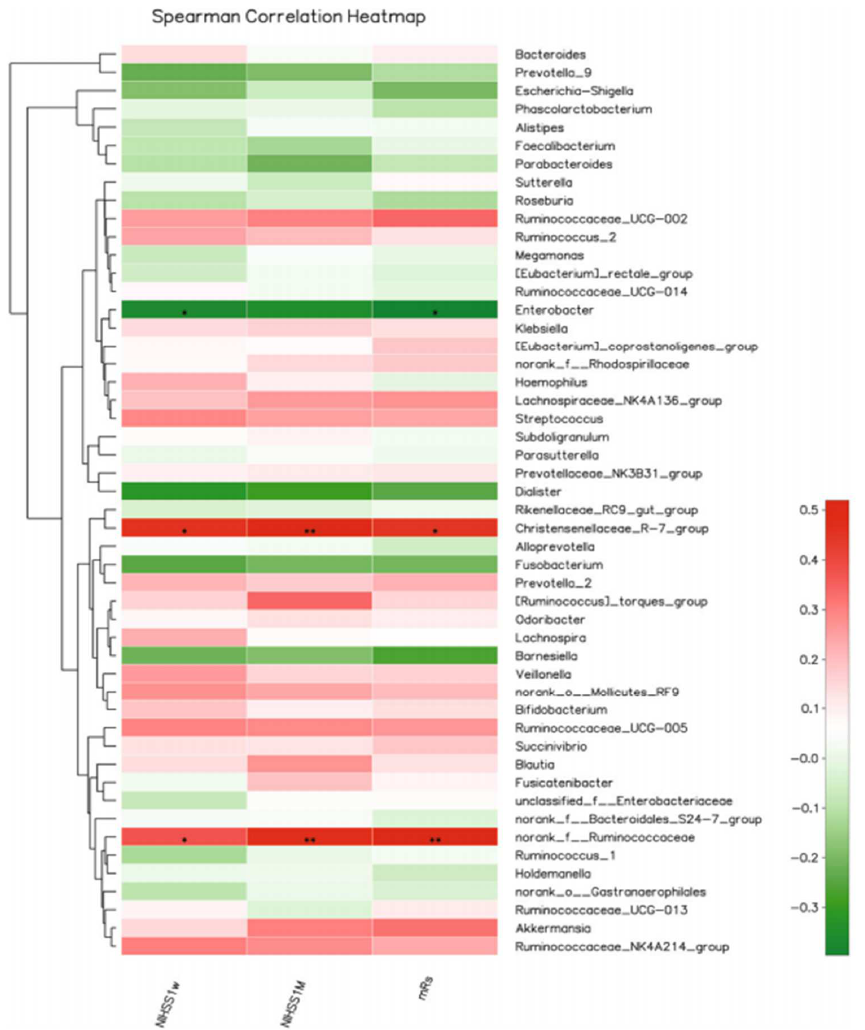
Figure 5. Heat map of Spearman correlation coefficient analysis, including the National Institutes of Health Stroke Scale (NIHSS) after 7 and 30 days and modified Rankin scale (mRS), was used to explore the relationship between the gut microbiota and severity or outcome of cerebral ischemic stroke patients. * p < 0.05, ** p < 0.01, *** p < 0.01. The figure is reused as per journal copyright per- mission